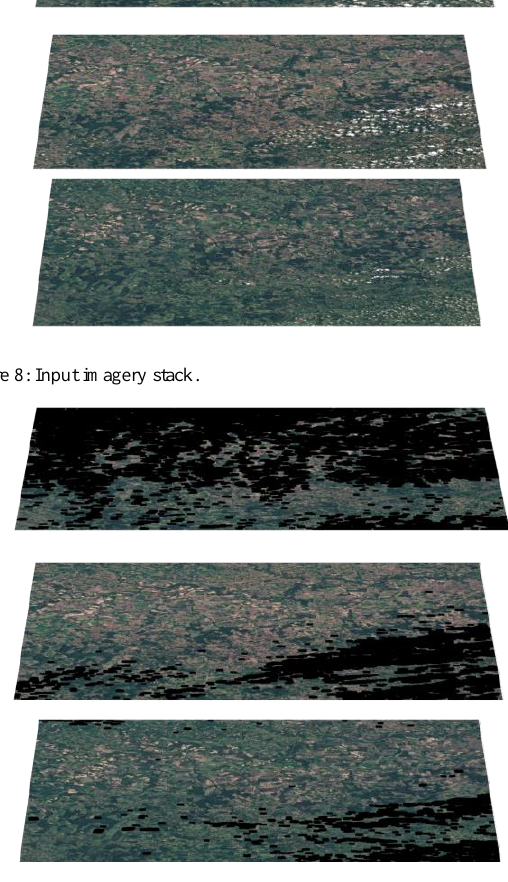
Figure 9: Input imagery stack with cloud